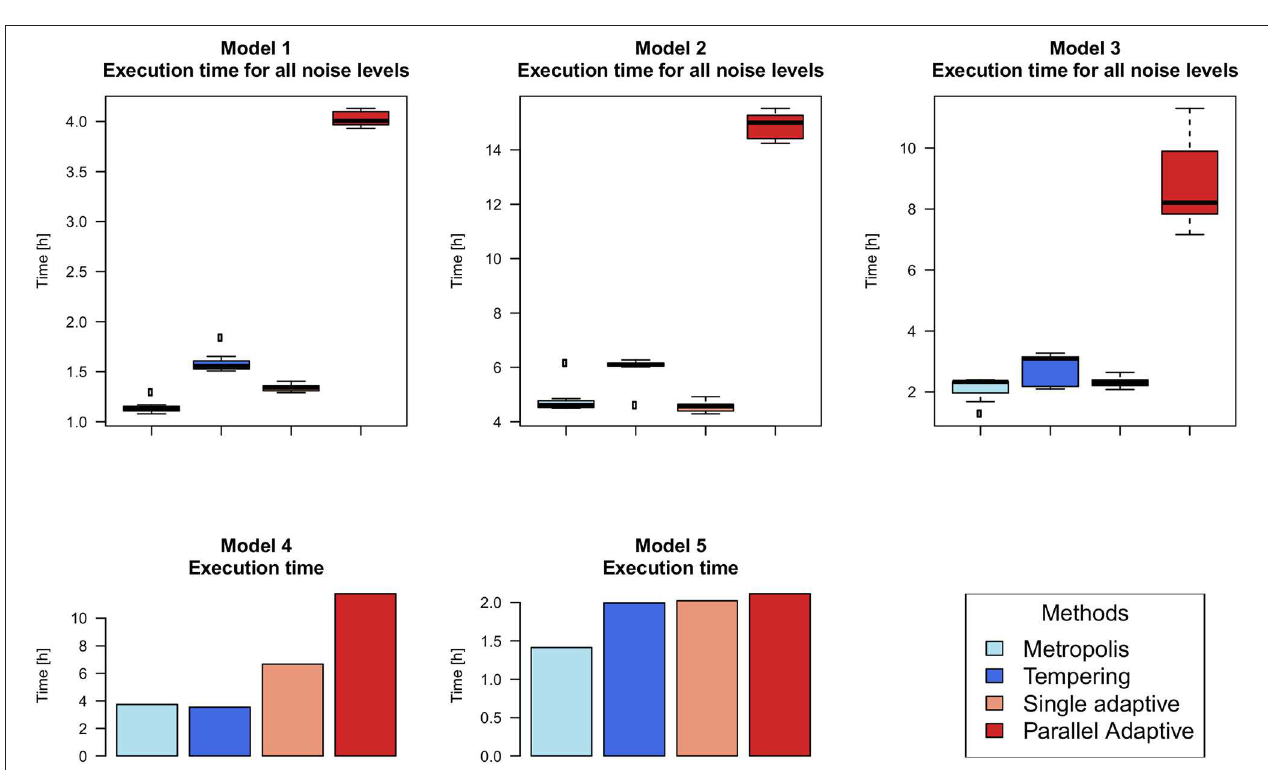
FIGURE 4 | Empirical calculation times for 1 million iterations with different MCMC algorithms based on the implementations used in this paper. For models 1–3 boxplots depict the distribution due to repeats with different simulated noise levels. Time execution for models 4 and 5 is represented with barplots. Models were run on a 24 core Intel Xeon E5-2697 machine with 128 GB